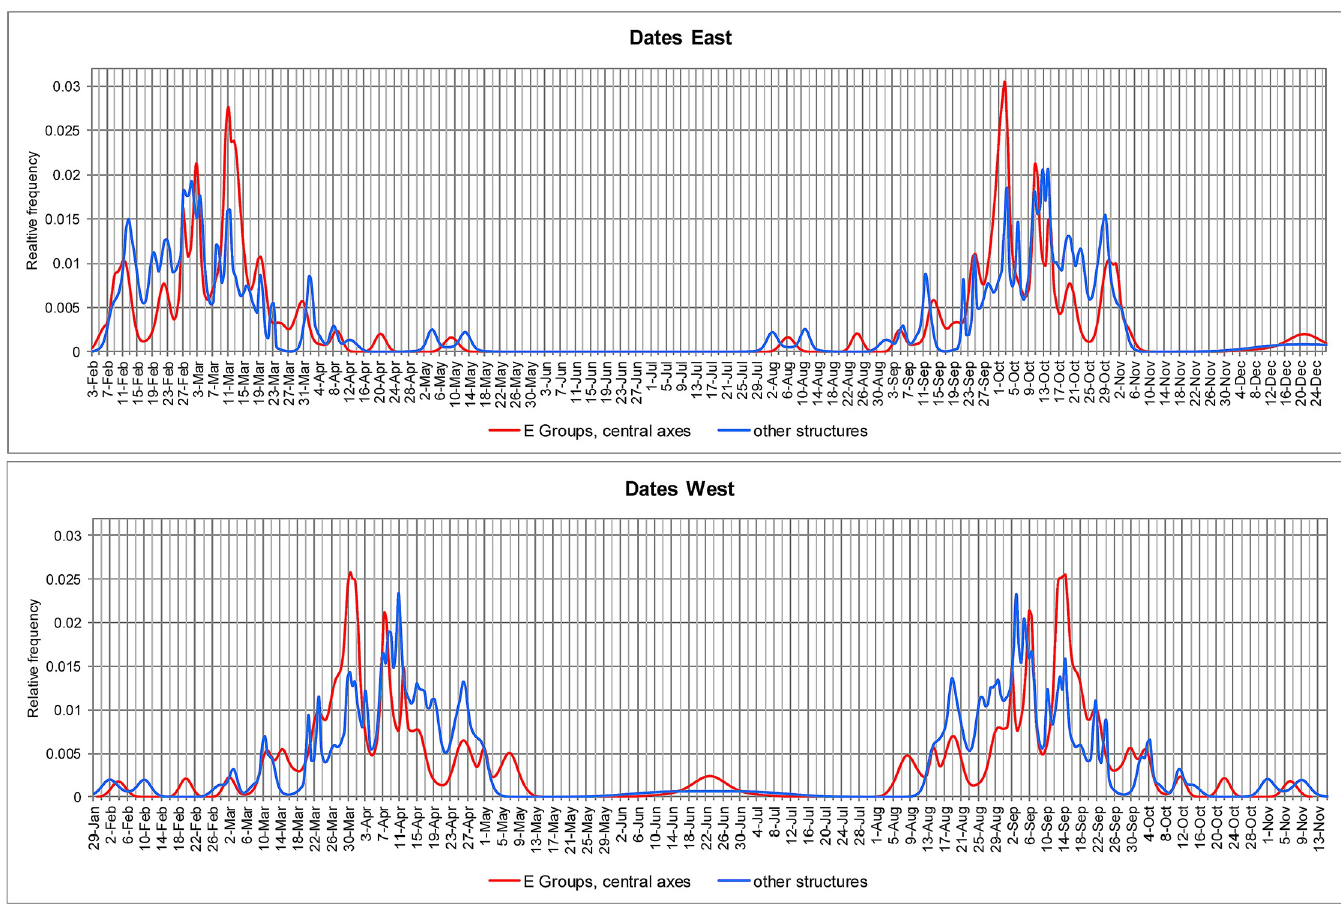
Fig 5. Relative frequency distributions of dates marked by solar